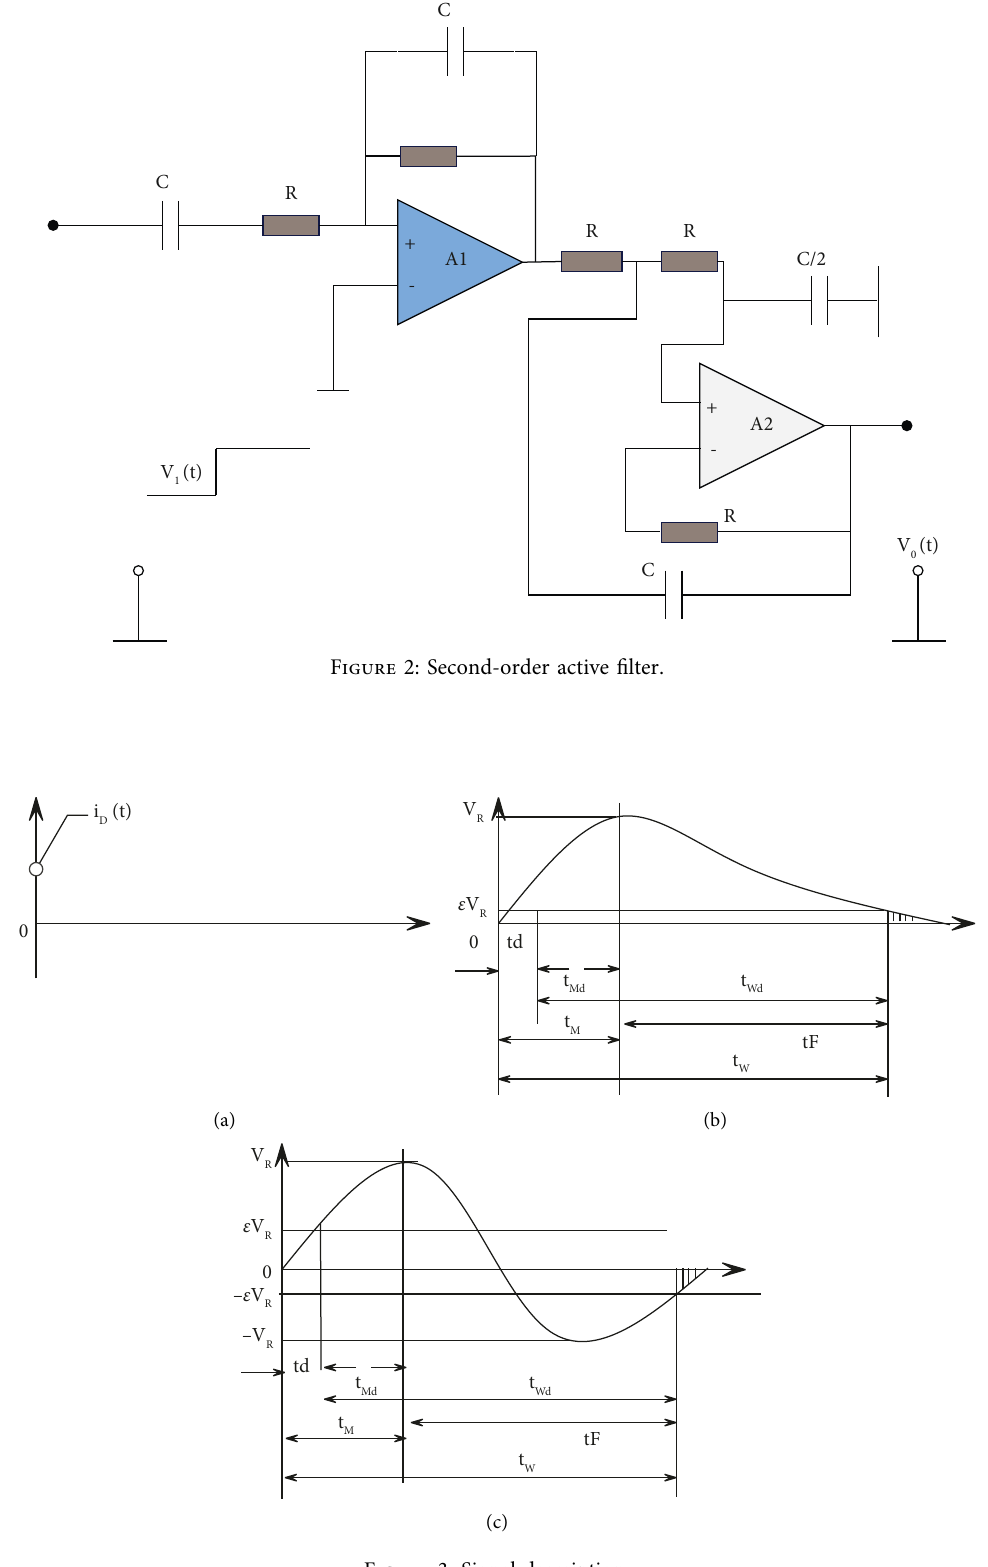
Figure 3: Signal description.